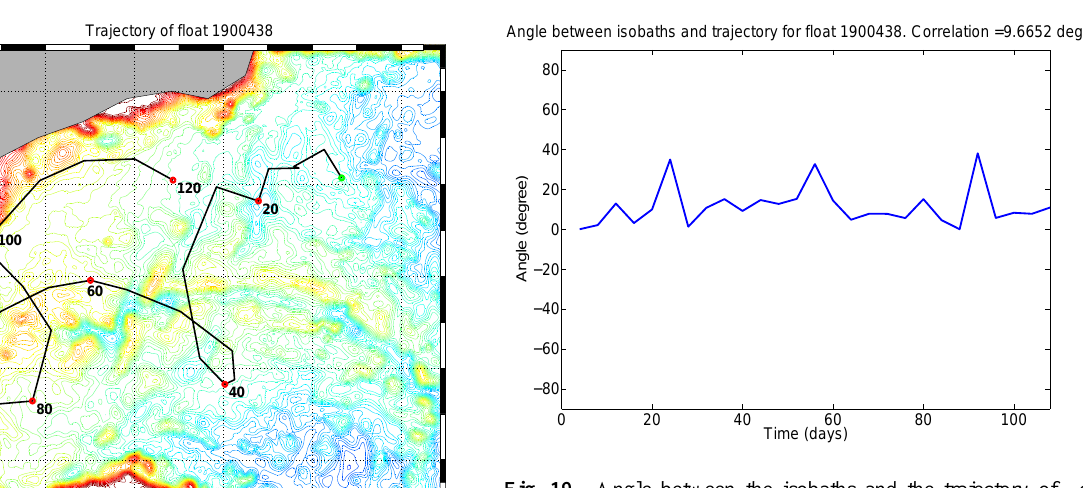
Figure 20: Vertical sections of temperature (in o C , left) and of salinity (right) along float 1900438 trajectory.